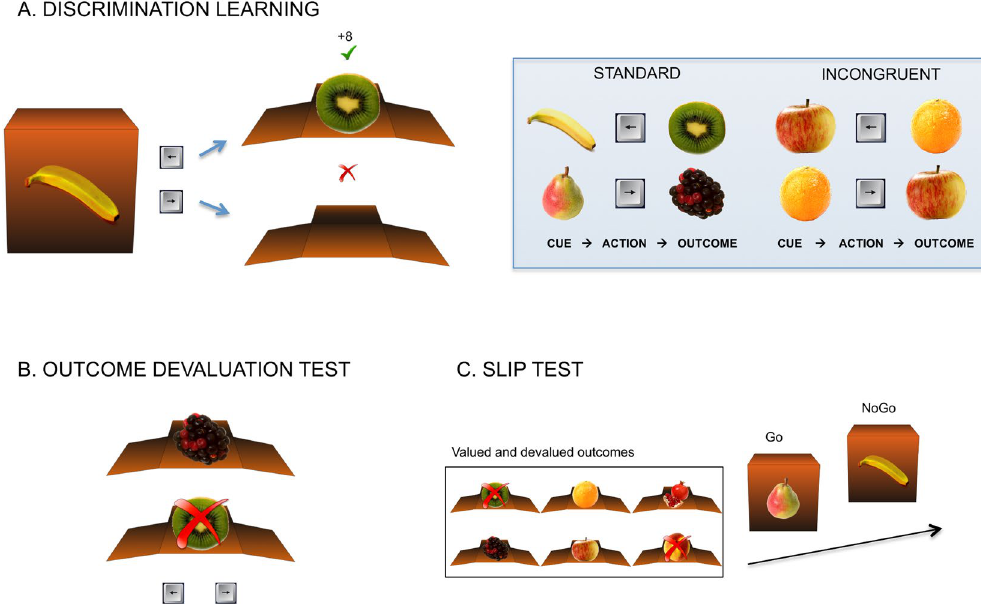
Figure 1. Experimental paradigm. ( A ) The Discrimination Learning Task performed in the scanner is shown. In the illustrated example, subjects are presented with a closed box and a banana picture (cue) in front of it. They are asked to press the key associated with the banana, which they learn via feedback presented after they make their choice. If the subject presses the correct key, then the box opens with another fruit inside and a number showing the points earned. If the wrong key is pressed or response is omitted, an empty box opens. In the standard condition, a given fruit is only used either as cue or as outcome (but not as both), whereas in the incongruent condition, a given fruit is used as cue in some trials and as outcome in others. The task also includes a control condition, in which an arrow is presented above the box instead of a fruit and shows the direction of the key to be pressed. The box then opens with a blue circle displayed above it. ( B ) The Outcome Devaluation Test is shown. In this example trial, two open boxes are presented. The “X” on kiwi indicates that this fruit is devalued and no longer offers points. Therefore, the correct response is the right key, which led participants to the valuable outcome (blackberry) during the learning phase. ( C ) The Slip Test is illustrated. At the beginning of each block, subjects are presented with outcome fruits to obtain in the upcoming set of trials. Unlike the learning task, 2 fruits (out of 6 in a block) are devalued and collecting them would result in subtraction of points. Those devalued outcomes are marked with ‘X’s. In the example shown, kiwi is an outcome to avoid, therefore, when presented with a banana, subjects should not press any key to avoid loss of points. The subjects are asked to collect the valuable fruits. Since the pear leads to a valuable fruit (blackberry), the subjects should press the correct key (right) in response to pear. The fruit images in this figure were obtained from the food-pics database 38 for illustration purpose and their brightness was adapted for this figure. The license agreement is available on